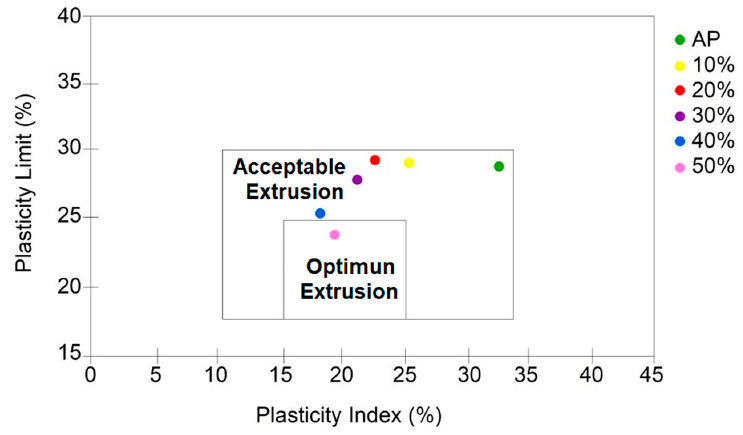
Figure 6. Extrusion prognosis using the Atterberg limits of ceramic masses.